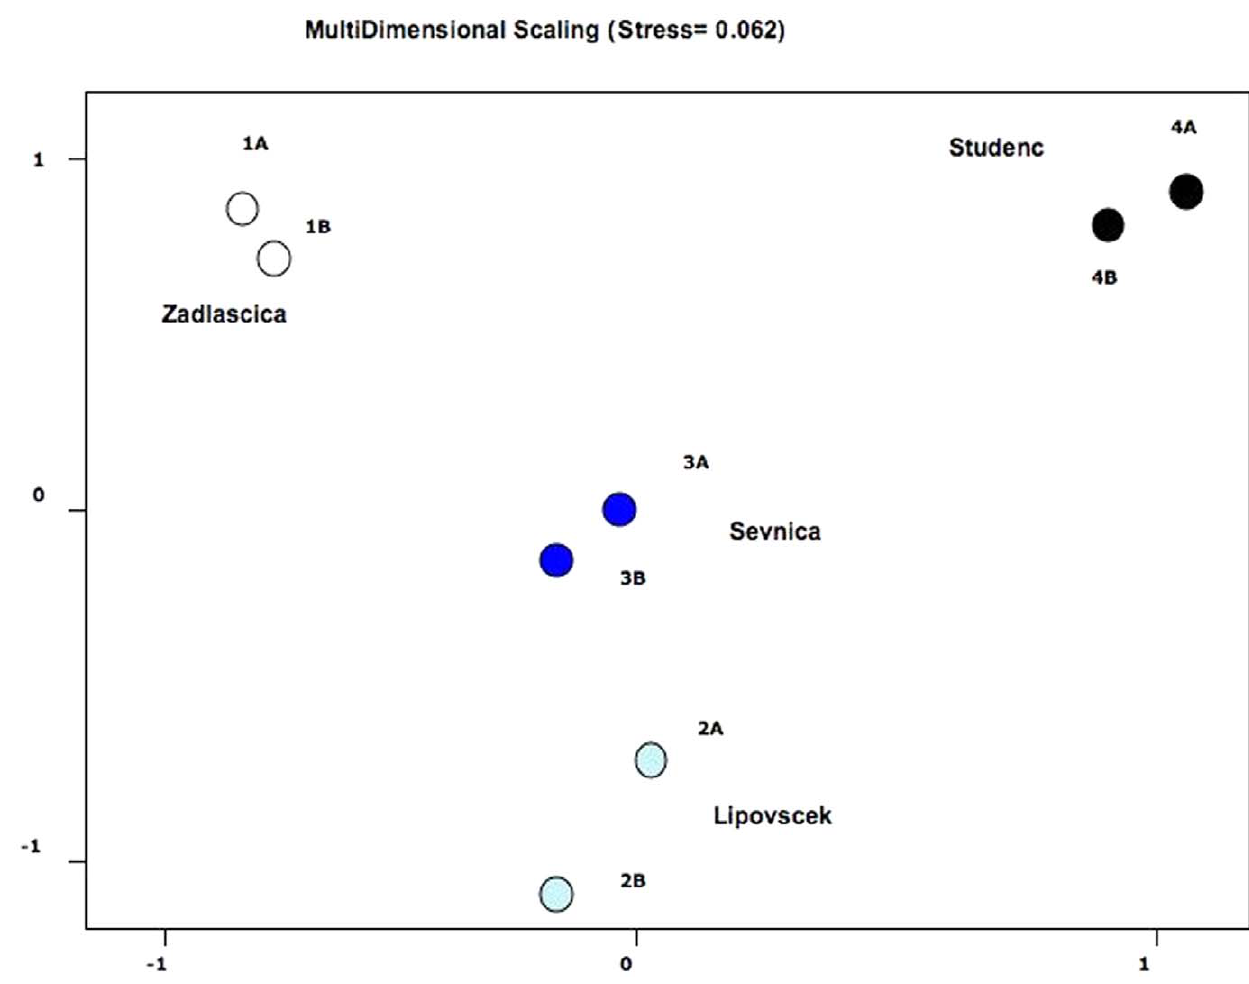
Figure 2. Plots of the values of the first and second principal coordinates obtained from Cavalli-Sforza and Edwards (1967) chord distances at all loci. Samples labeled as in Table 3. A=pre-flood samples; B=post-flood samples. Stress value=0.062.